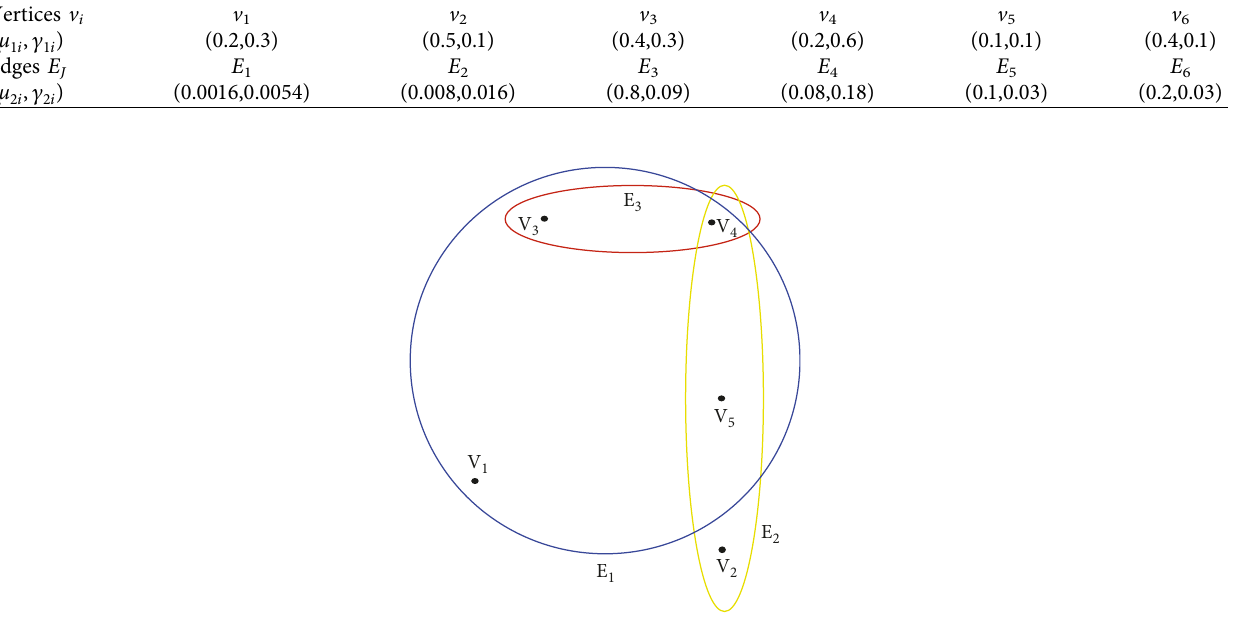
Figure 2: Semi– c -strong edge of IFHG H .